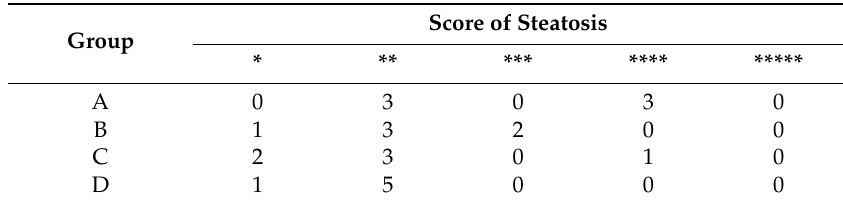
Table 2. Degree of hepatic steatosis in type 2 diabetic rats (HFD/STZ) submitted to physical training and/or treated with beta-glucans (30 mg/kg/day).